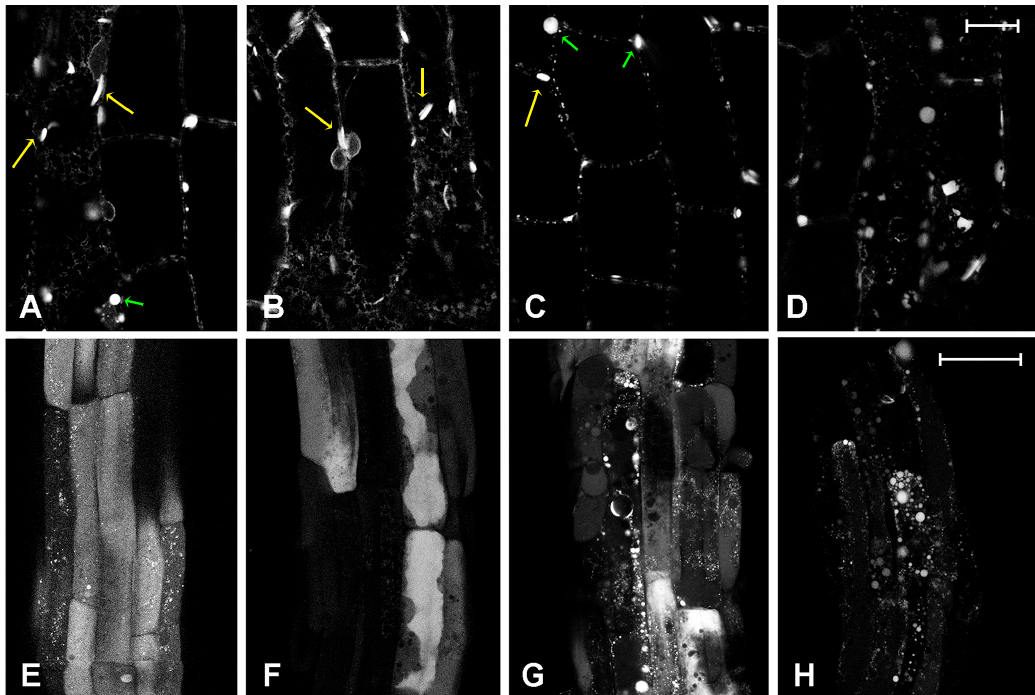
Figure 4. Fluorescent patterns of AleuGFP vacuolar marker, in different tissues. ( A ) Single confocal section of hypocotyl’s cells in control; ( B ) Hypocotyl’s cells treated with 5 mg/L (13 µM) kiteplatin; ( C ) 5 mg/L (13 µM) oxaliplatin or ( D ) 5 mg/L (17 µM) cisplatin. Long yellow arrows indicate endoplasmic reticulum (ER) bodies while short green arrows indicate different large round-shaped compartments. Four confocal sections projection of young root at the end of elongation stage (emerging trichoblasts) in ( E ) control conditions or treated with ( F ) 10 mg/L (26 µM) kiteplatin, ( G ) 10 mg/L (25 µM) oxaliplatin, or ( H ) 10 mg/L (33 µM) cisplatin. Scale bar: 20 µm.